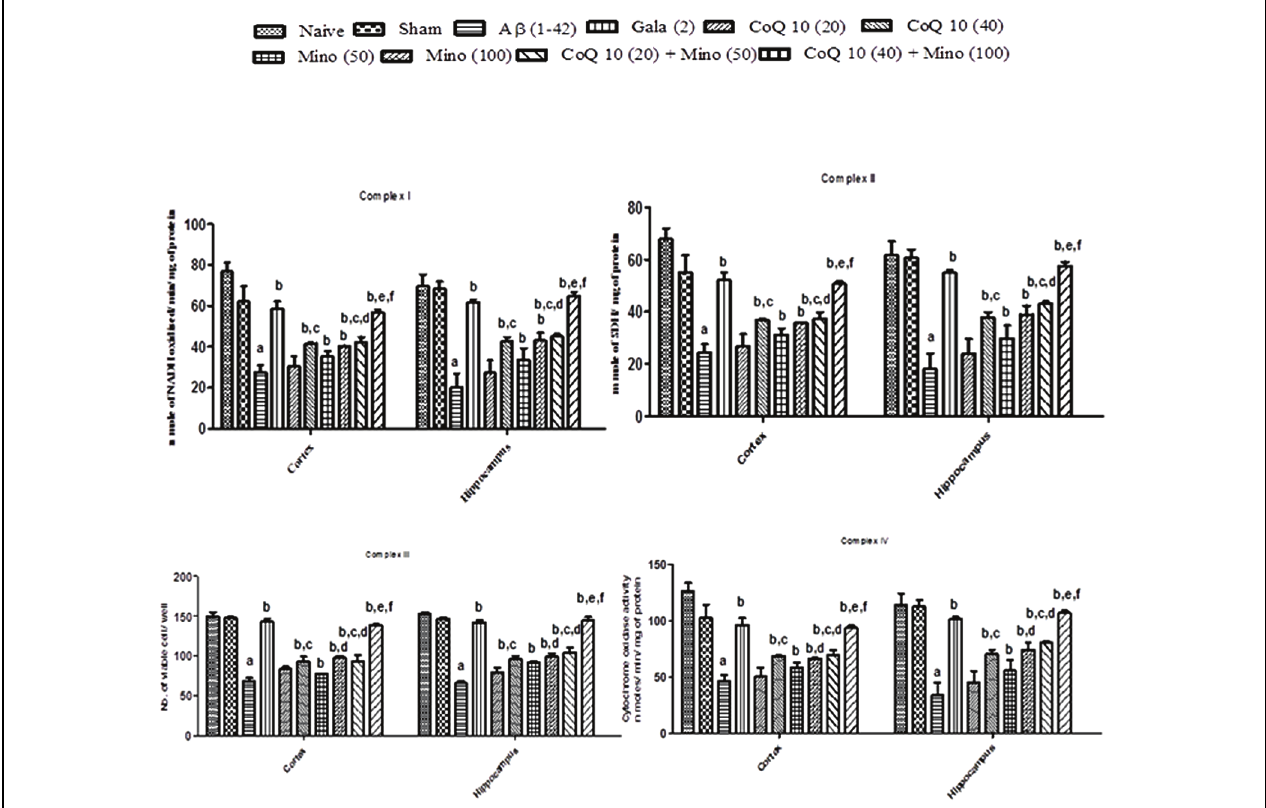
FIGURE 4 | Effect of CoQ10 and minocycline alone and in combination on mitochondrial respiratory enzymes in the hippocampus and cortex region of A β (1-42) treated rats. Data expressed as mean ± SEM a P < 0.05 compared to sham group; b P < 0.05 compared to A β (1-42) treated group; c P < 0.05 compared to CoQ10 (20) group; d P < 0.05 compared to Mino (50) group; e P < 0.05 compared to CoQ10 (40); f P < 0.05 compared to Mino (100) group (One way ANOVA followed by Tukey’s test). (A β , Amyloid beta; Gala, Galantamine; CoQ10, Coenzyme Q 10; Mino, Minocycline).